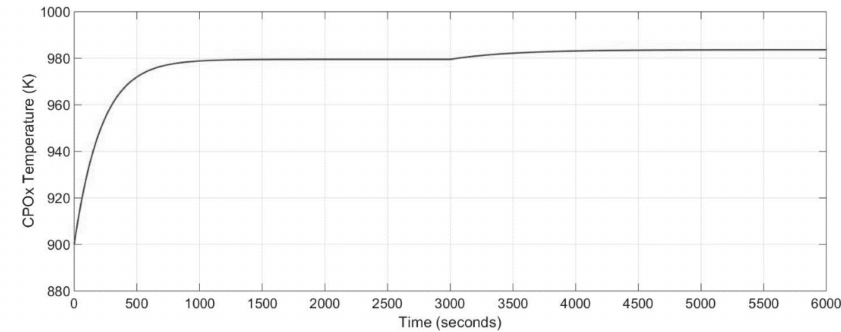
Figure 8. Dynamic response of the CPO x reformer temperature for different lambda